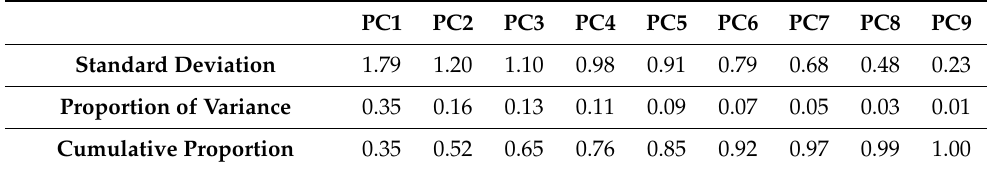
Figure 2. PCA of 92 RILs for nine traits based on mineral, yield, and agronomic traits. Table 3. Importance of components.